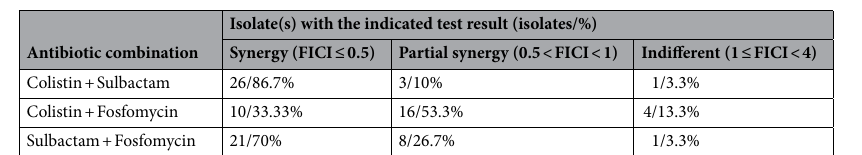
Table 2. Result of checkerboard synergy test of three antibiotic combinations against 30 colistin-resistant A. baumannii clinical isolates.